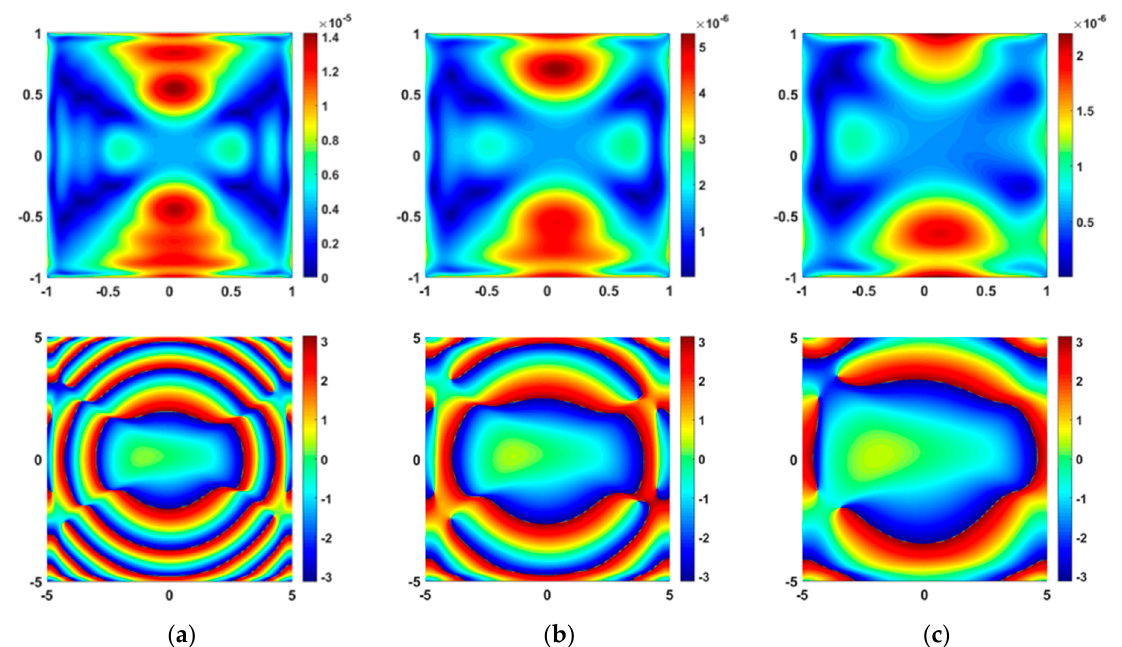
Figure 8. Intensity and phase distribution of electromagnetic vortex waves with transmission distance of ( a ) 1 km, ( b ) 5 km and ( c ) 10 km for multiplexing l = 1, 3, 5 under moderate turbulence conditions, with adaptive compensation.